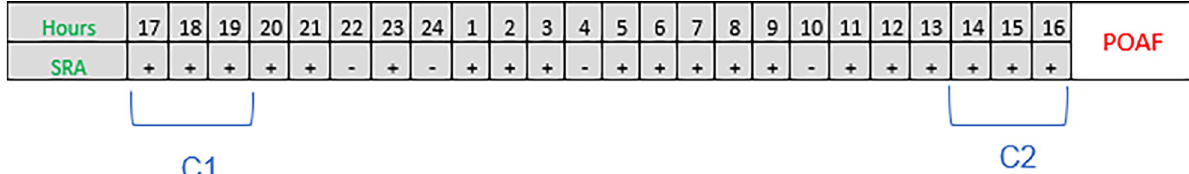
Fig 5. Example of a patient with POAF at 16:00 on the second postoperative day. Note that in this patient there is a predominance of positive results, characterizing a patient at risk for POAF.